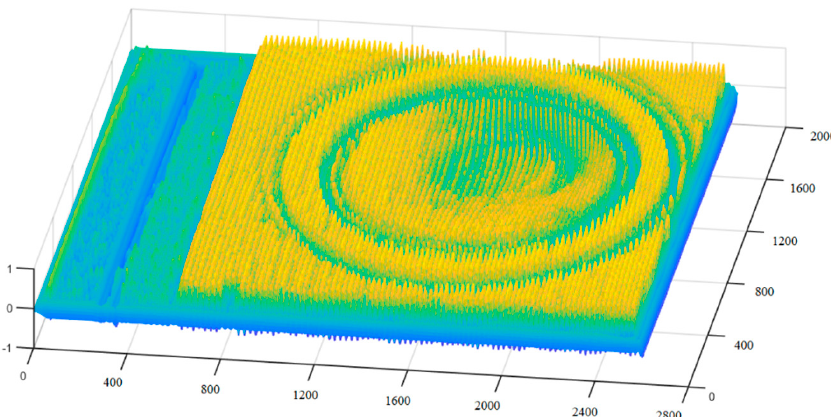
Figure 7. Correlation between a left image ellipse versus the overall possible 21 × 21 facets of the right image.